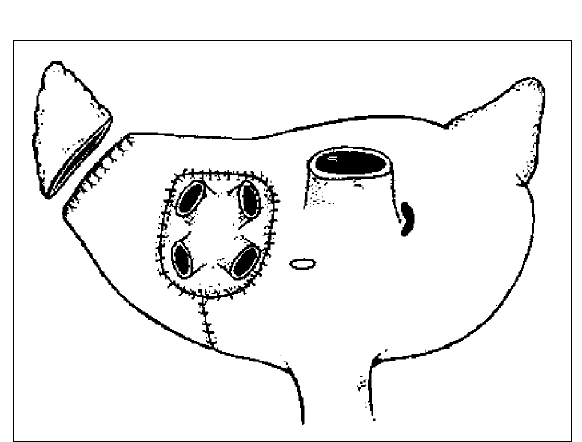
Fig. 1 - IVP visão anatômica e esquemática.